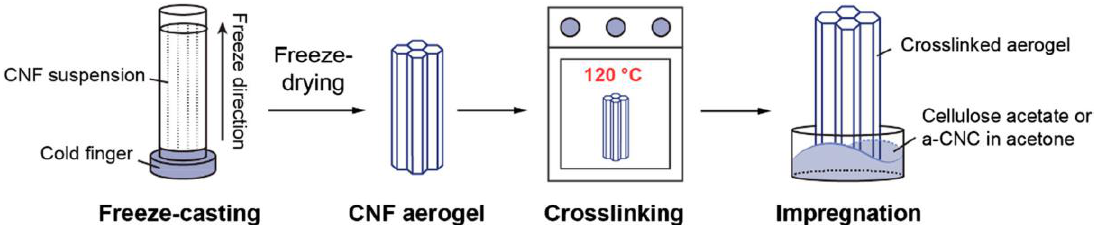
Figure 5. Sketches showing the process of unidirectional freeze casting followed by freeze drying to make the acetate-functionalized nanocellulose aerogels for CO 2 adsorption. Reproduced under